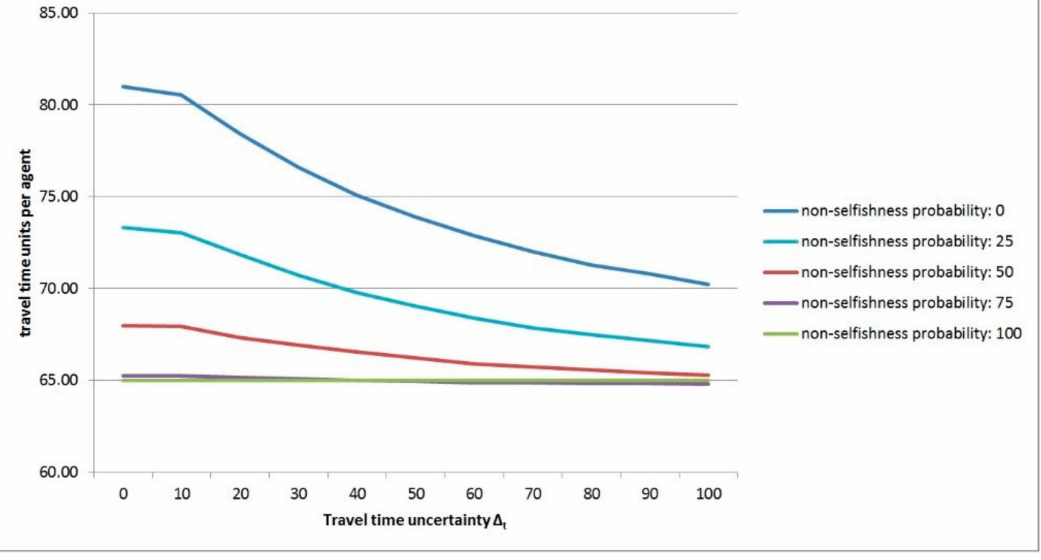
Figure 4. Diagram showing the latency values per agent for given non-selfishness probabilities over varying travel time uncertainty values ∆ t